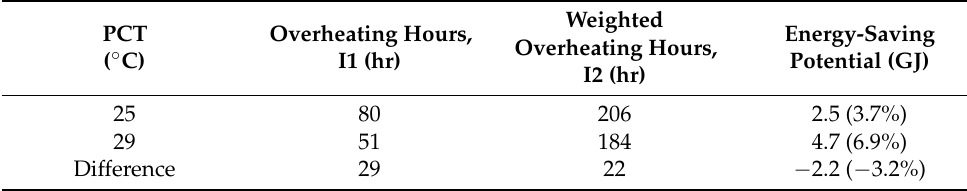
Table 5. Comparison of annual efficacy of a PCT of 25 ◦ C or 29 ◦ C in Taipei. PCT Overheating ( ◦ C)